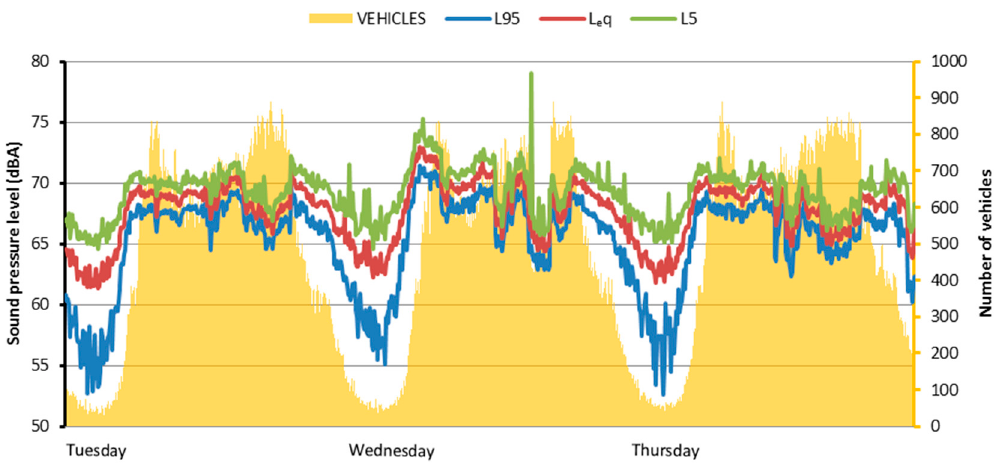
Figure 3. Noise level indicators and number of road vehicles (on 5-min intervals) during 3 days of the survey period. L eq : Equivalent sound pressure levels.